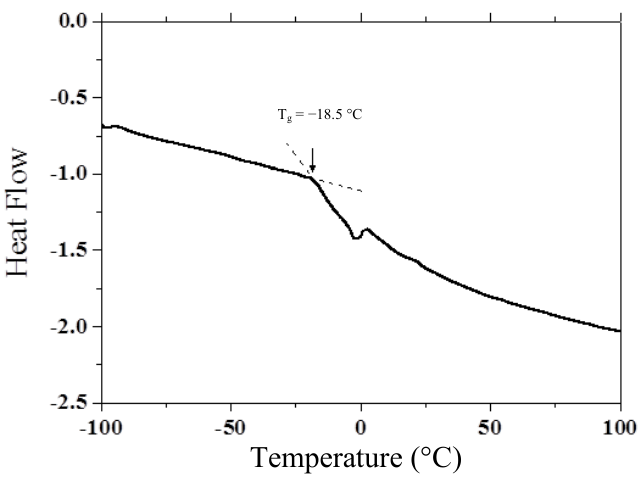
Figure 4. Differential scanning calorimetry (DSC) thermogram of photorefractive (PR) polymer composite.